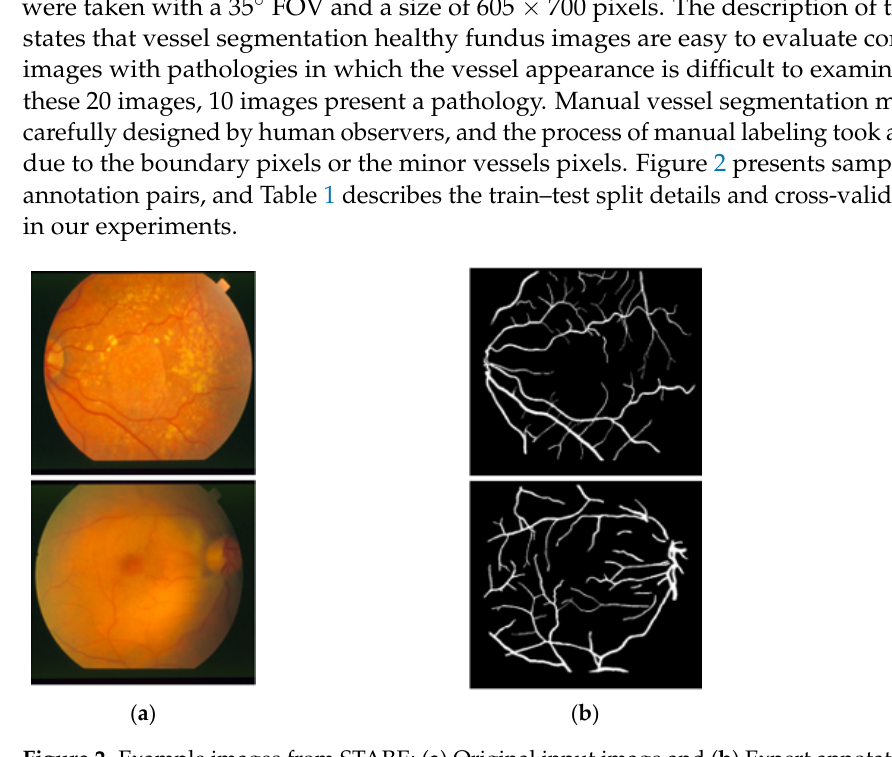
Figure 2. Example images from STARE: ( a ) Original input image and ( b ) Expert annotation mask.